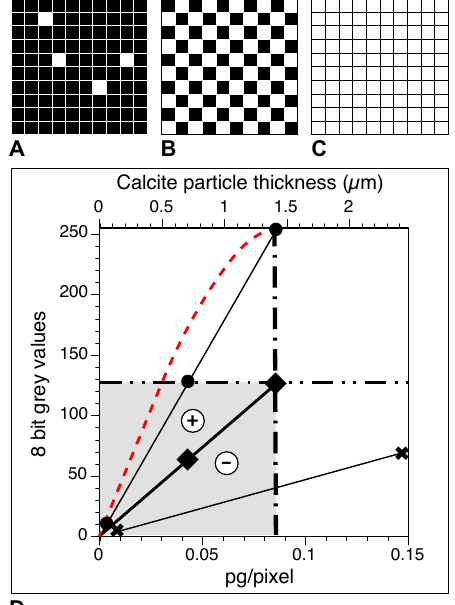
= shape factor introduced by Young and Ziveri (2000); the 2 s values given by Young and Ziveri (2000) were used to 4 s CPR-­‐Method, Bollmann 2013 19 shown in Figure 5a-c using XPL assuming a uniform particle thickness of 1.41 µ m. Here a 1 random orientation of particles is assumed, leading to a different relationship between grey values 2 and weight as compared to the curve using the CPL method (black dots). The maximum average 3 grey value per pixel can not exceed 126.5 (253/2). 4 The dashed single dotted vertical line ( – ® –) indicates the boundary (thickness of 1.41 µm and 5 weight of 0.086 pg assuming a pixel size of 0.0225 µm 2 ), beyond which, the weight of calcite can 6 not be determined using the relationship between grey values and thickness of a pixel. The 7 dashed double dotted horizontal line ( – ® ® –) indicates the boundary, beyond which, the grey 8 value can not be used to determine the weight of a pixel in XPL. All calibration points using the 9 empirical calibration method of Beaufort (2005) should lie within the area defined by the grey 10 value and weight boundaries if particle orientation is random. ⊕ = over-exposure and  = under- 11 exposure in XPL. 12 Table 1. Comparison of published weight estimates. 15 N = Number of measurements; STDEV = Standard deviation of weight estimates reported; K s = 16 shape factor reported by Young and Ziveri (2000). Values for maximum length of single 17 coccoliths for E. huxleyi were reported by Bollmann and Herrle (2007), for Gephyrocapsa spp. by 18 Bollmann (1997) and Bollmann et al. (2010), for F. profunda by Quinn et al. (2005), for C. 19 leptoporus by Knappertsbusch et al. (1997), for C. pelagicus by Parente et al. (2004). Values for 20 all other species were taken from Young and Ziveri (2000). Please note that the average length 21 for populations are significantly smaller, for example, for E. huxleyi the maximum average length 22 of a Holocene sample is smaller than 4 µm although the maximum size of a single coccolith can 23 be up to 6 µm Bollmann and Herrle (2007). 24 25 Supplement 1 26 Grey scale converted interference colours. 27 28